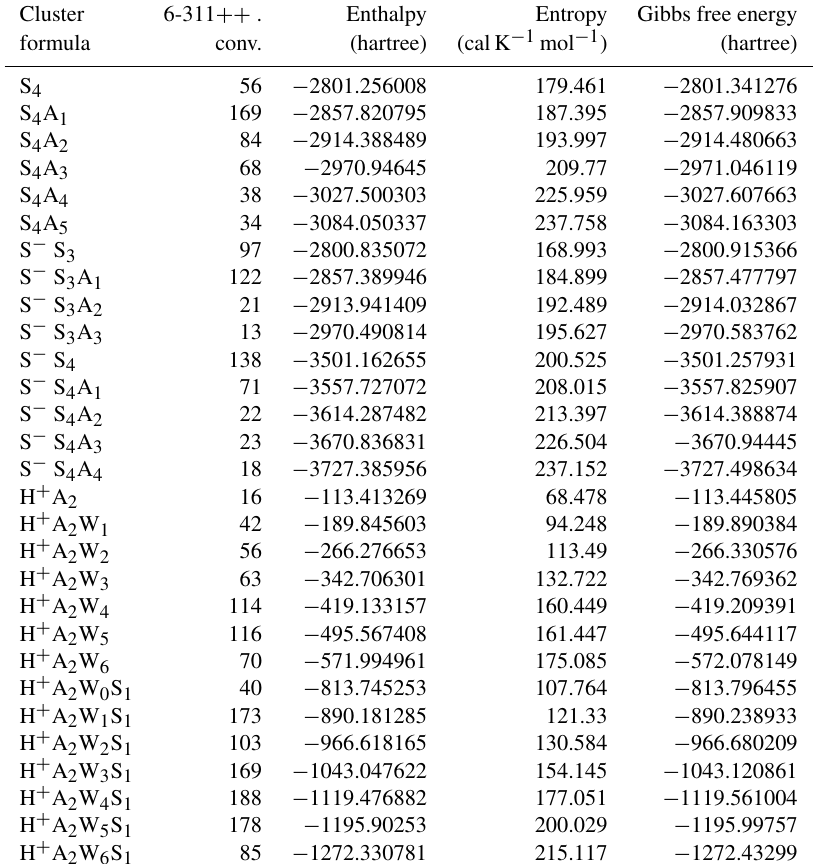
Table A1. Number of isomers successfully converged at the 6-311 level for selected clusters, along with the enthalpy, entropy, and Gibbs free energy of the most stable isomers (1 hartree = 627.5kcalmol − 1